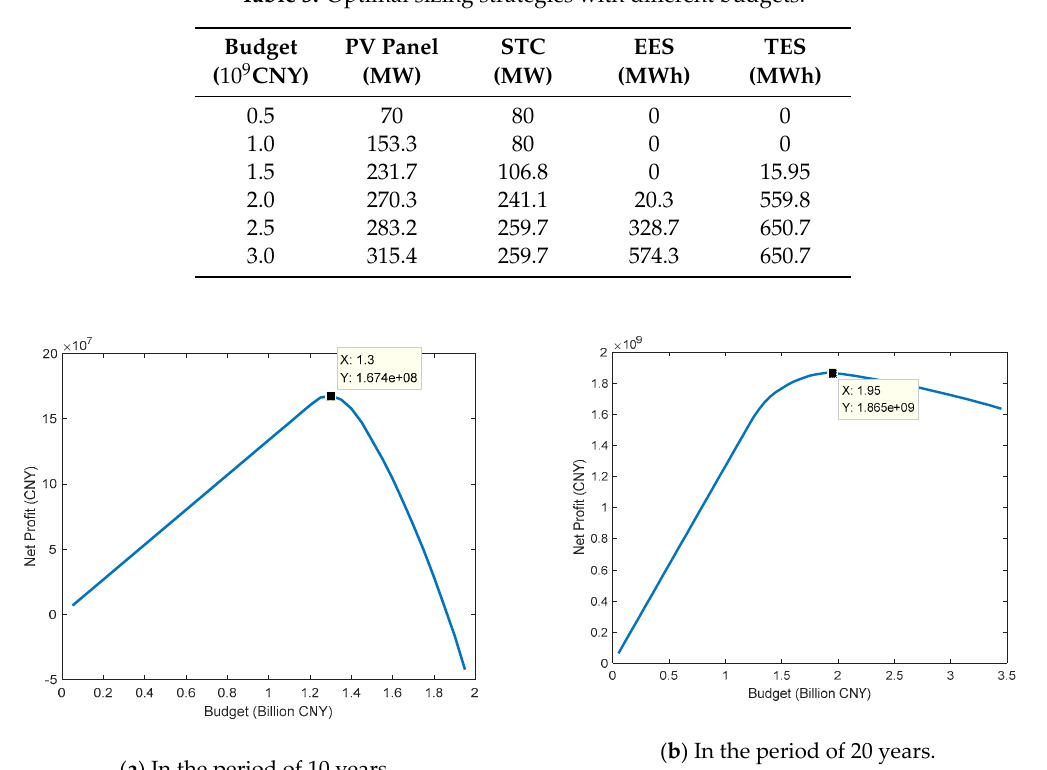
Figure 5. Net profit in a certain period. Table 4. Optimal sizing strategies with different costs of solar panel and EES.